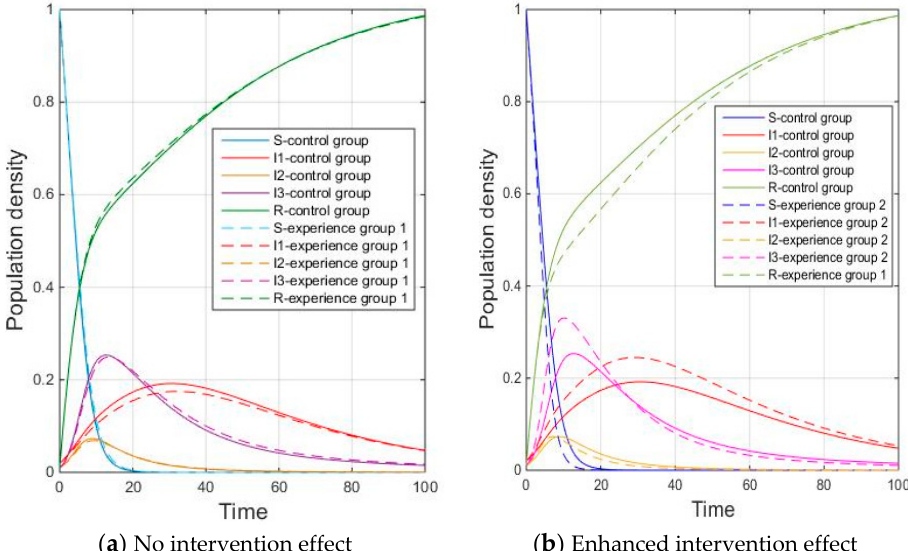
Figure 5. Impact of media intervention on public opinion evolution.